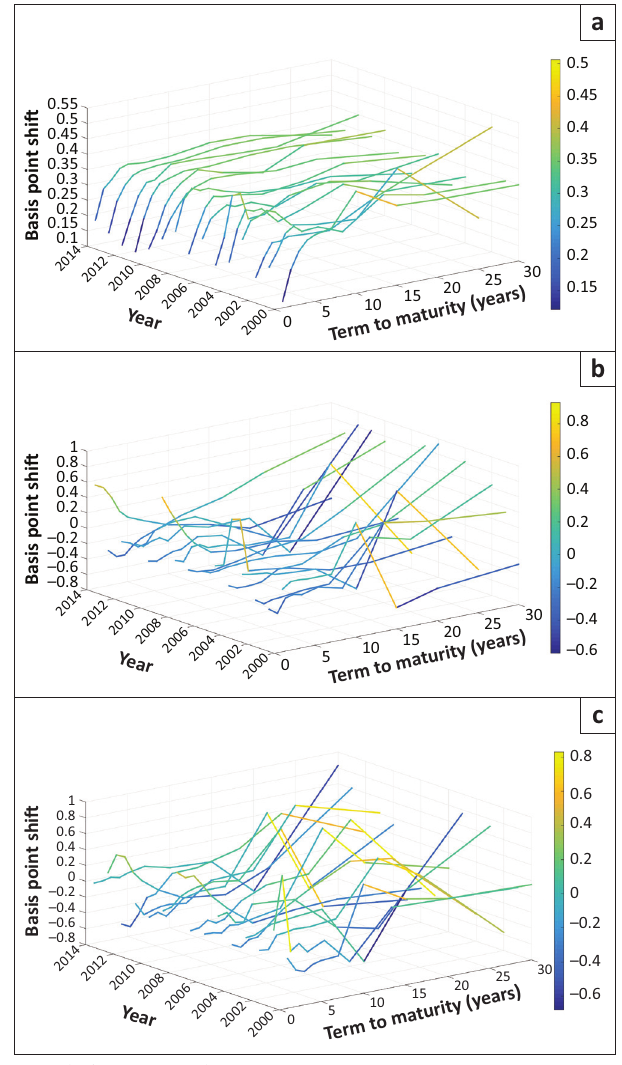
SA, South Africa; PC, Principal component. FIGURE 12: Three-dimensional representation of annual South African principal components for the period 1995–1999. SA, South Africa: (a) SA annual PC1; (b) SA annual PC2; (c) SA annual PC3.